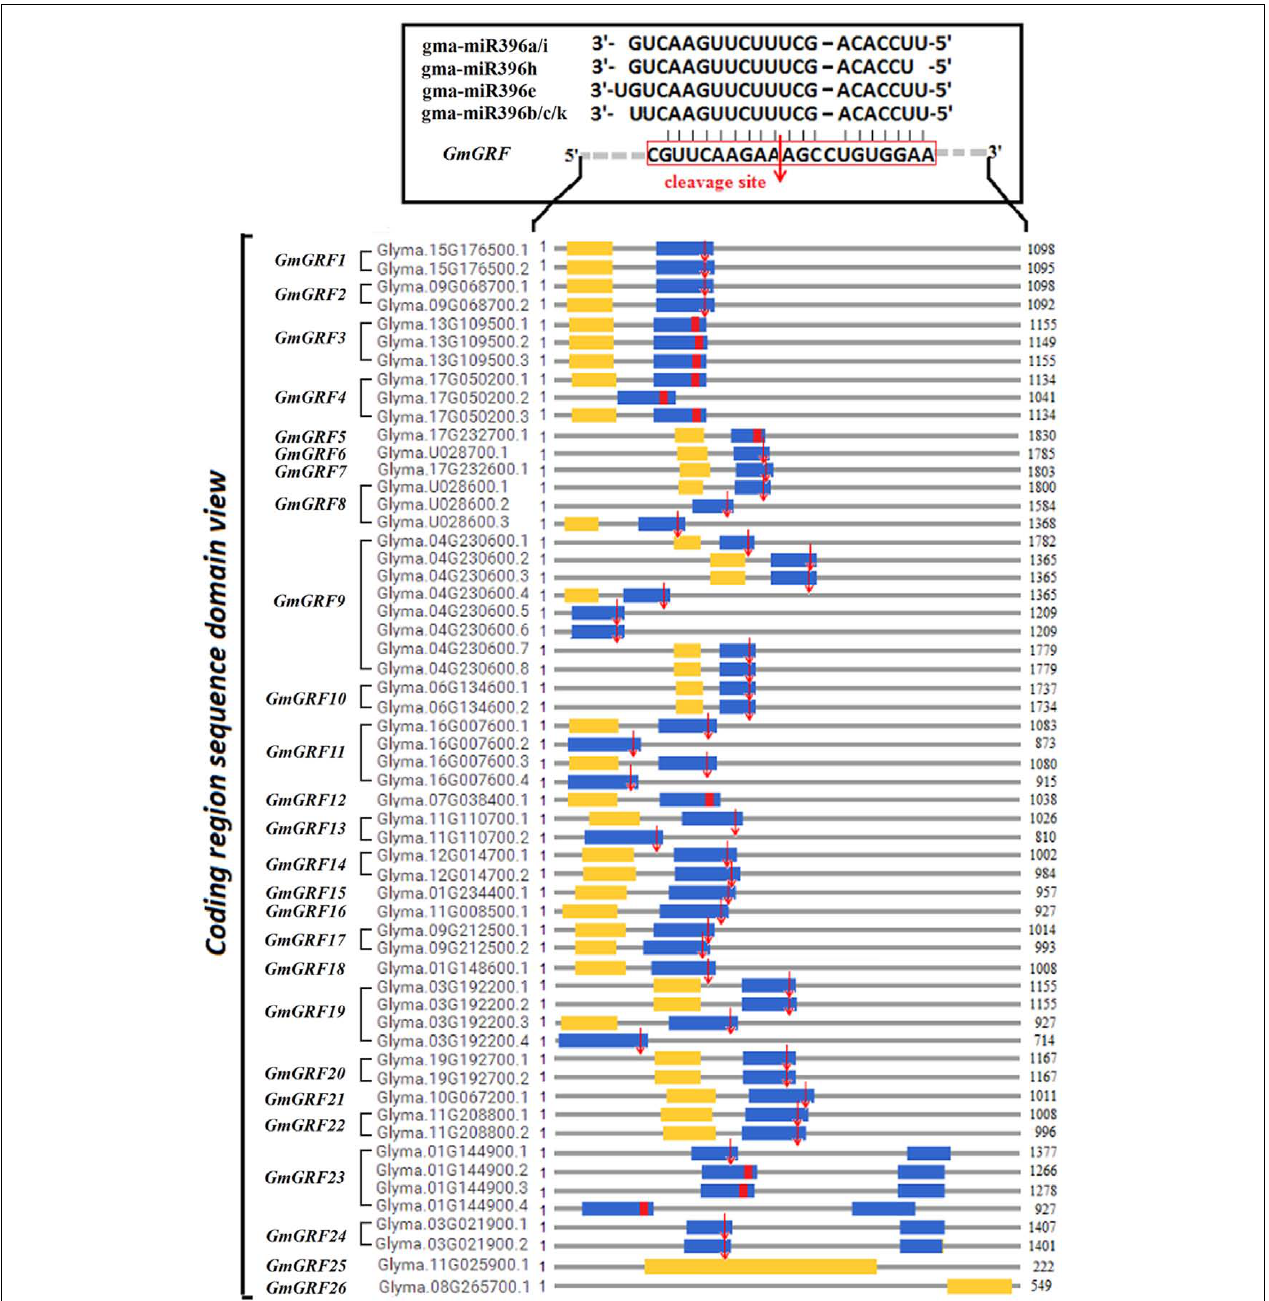
FIGURE 2 | Twenty GmGRFs verified to be cleaved by gma-miR396 using 5 (cid:48) RACE. Glycine max GmGRF family consists of 26 loci ( GmGRF1–GmGRF26 ), and 24 GmGRFs ( GmGRF1–GmGRF24 ) were predicted as target genes of gma-miR396a/b/c/e/h/i/k. Remaining two genes GmGRF 25 and GmGRF 26 were not predicted to be target genes of gma-miR396. Figure shows the sequence structure of 57 coding regions: blue squares, WRC conservative coding domain; yellow squares, QLQ conservative coding domain; red squares, predicted conservative cleavage site sequence; red arrows, cleavage sites validated by 5 (cid:48) RACE experiments in this